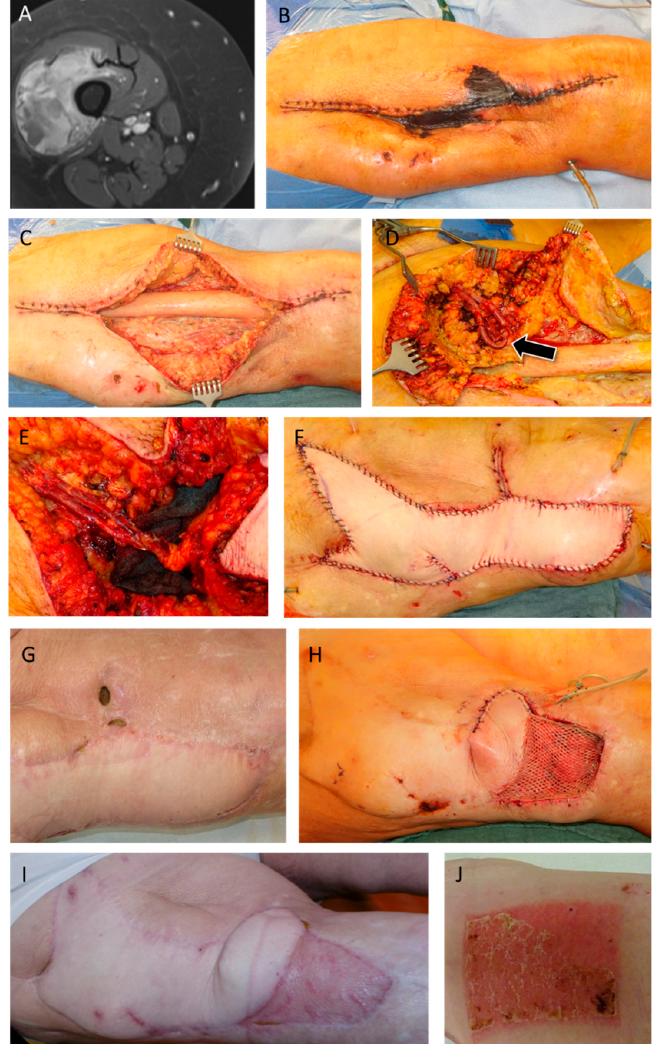
Figure 2. MRI of a 79 year-old female patient reveals an undifferentiated pleomorphic sarcoma in the right thigh ( A ). After resection and primary wound closure, skin necrosis occurred ( B ). After debridement ( C ) an arteriovenous loop was created ( D , arrow) and a VRAM flap was transplanted microsurgically and anastomosed to the AV Loop pedicle ( D – F ). After occurrence of wound healing disturbances at the medial border of the flap ( G ), a transposition of the distal flap and split skin grafting was performed ( H ). Postoperative clinical presentation after revision showing stable wound conditions ( I , J ).